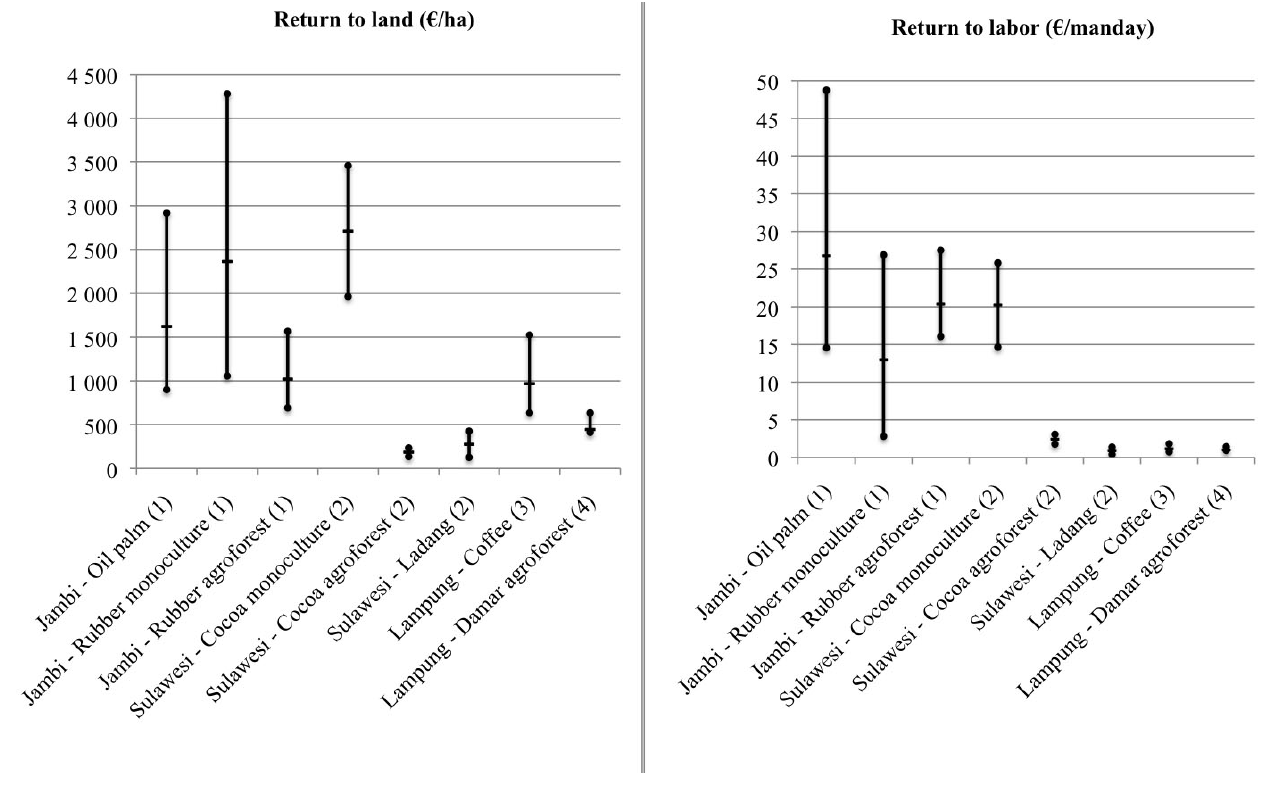
Fig. 4 . Profitability of the main land use systems for lowest, highest, and average farm gate prices in 2008–2009 (exchange rate of 13,500 IDR = 1 €). Sources: (1) Jambi: Adapted from Feintrenie et al. 2010 and complementary data from field survey, (2) Sulawesi: Adapted from Seeberg-Elverfeldt 2008 and complementary data from field survey, (3) Lampung: Personal communication from Yulia